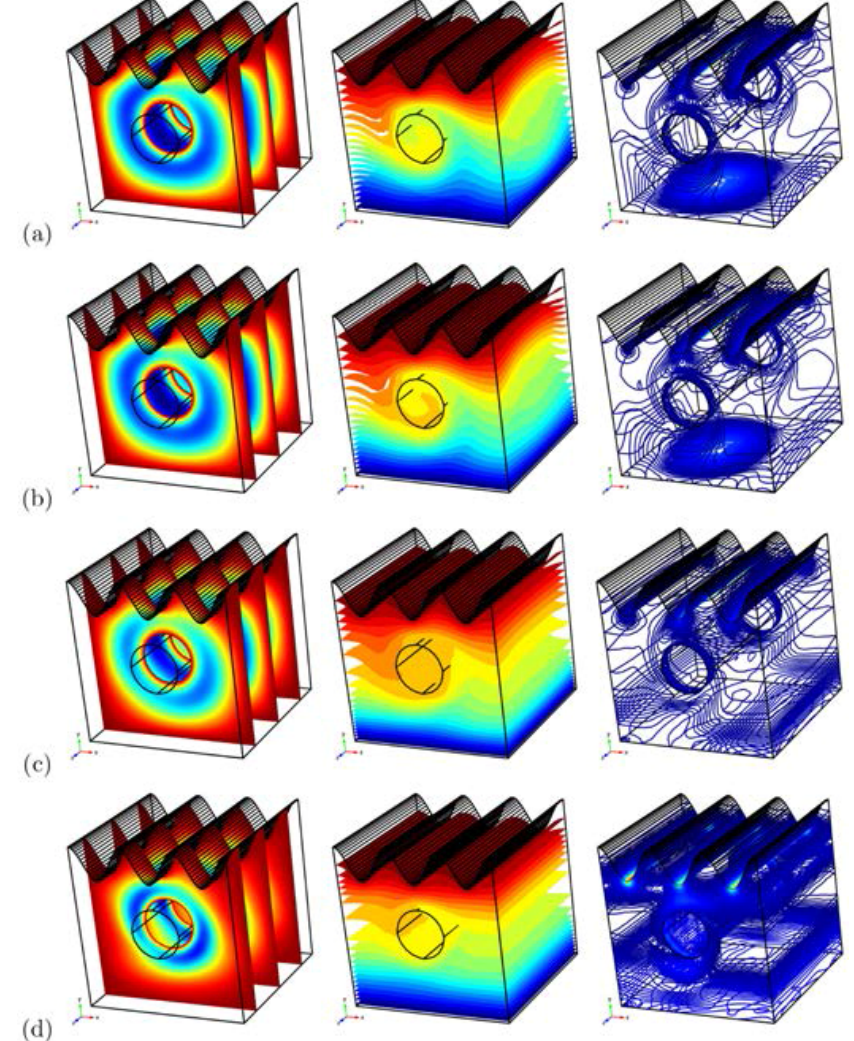
Figure 5. ( left ) 3D streamlines, ( centre ) isotherms and ( right ) isentropic lines: ( a ) Ri = 0.1, ( b ) Ri = 1, ( c ) Ri = 10 and ( d ) Ri = 100 for φ = 0.02 and N = 3. The effects of N on the 3D streamlines, isotherms and isentropy are depicted in Figure 6 for Ri = 10 and φ = 0.02. The wavenumber N has a clear impact on the flow cells, isotherms and isentropic line distributions. The flow inside the 3D wavy tank is represented by two streamline cells on the outer segments of the rotating cylinder.